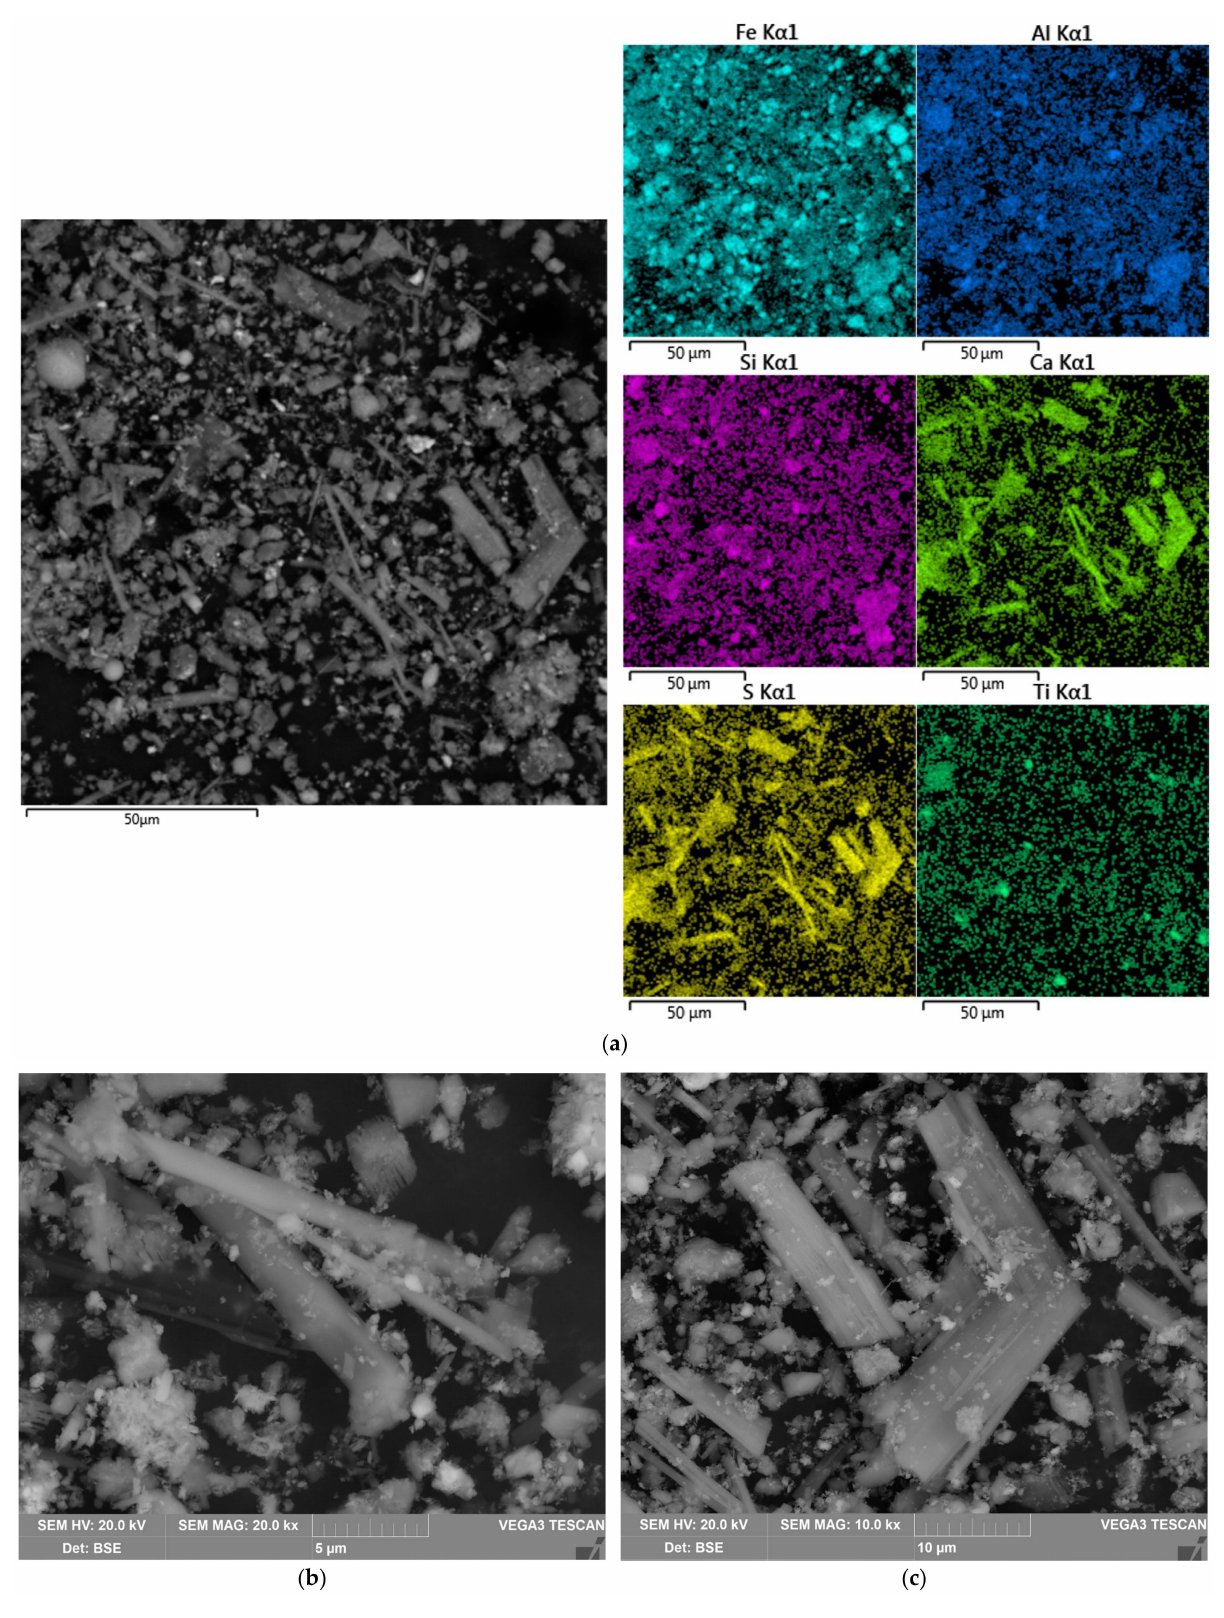
Figure 7. BSE images of: ( a ) The solid residue surface and elemental distribution of major elements (EDS mapping); ( b ) particles of the solid residue at a magnitude of 20,000 × ; ( c ) particles of the solid residue at a magnitude of 10,000 ×